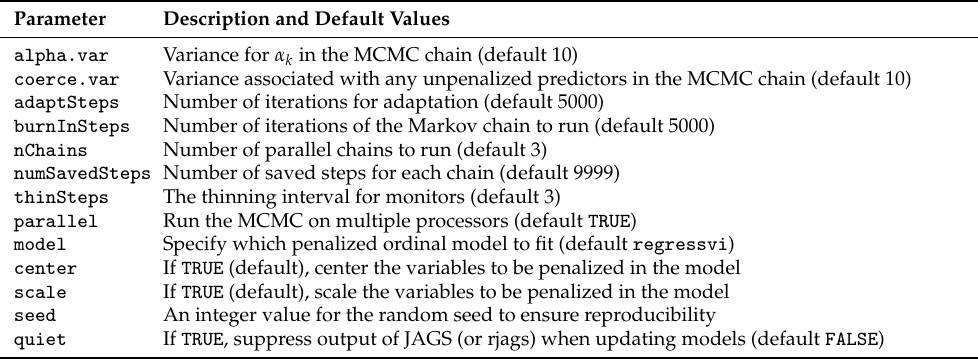
Table A1. ordinalbayes parameters available for all